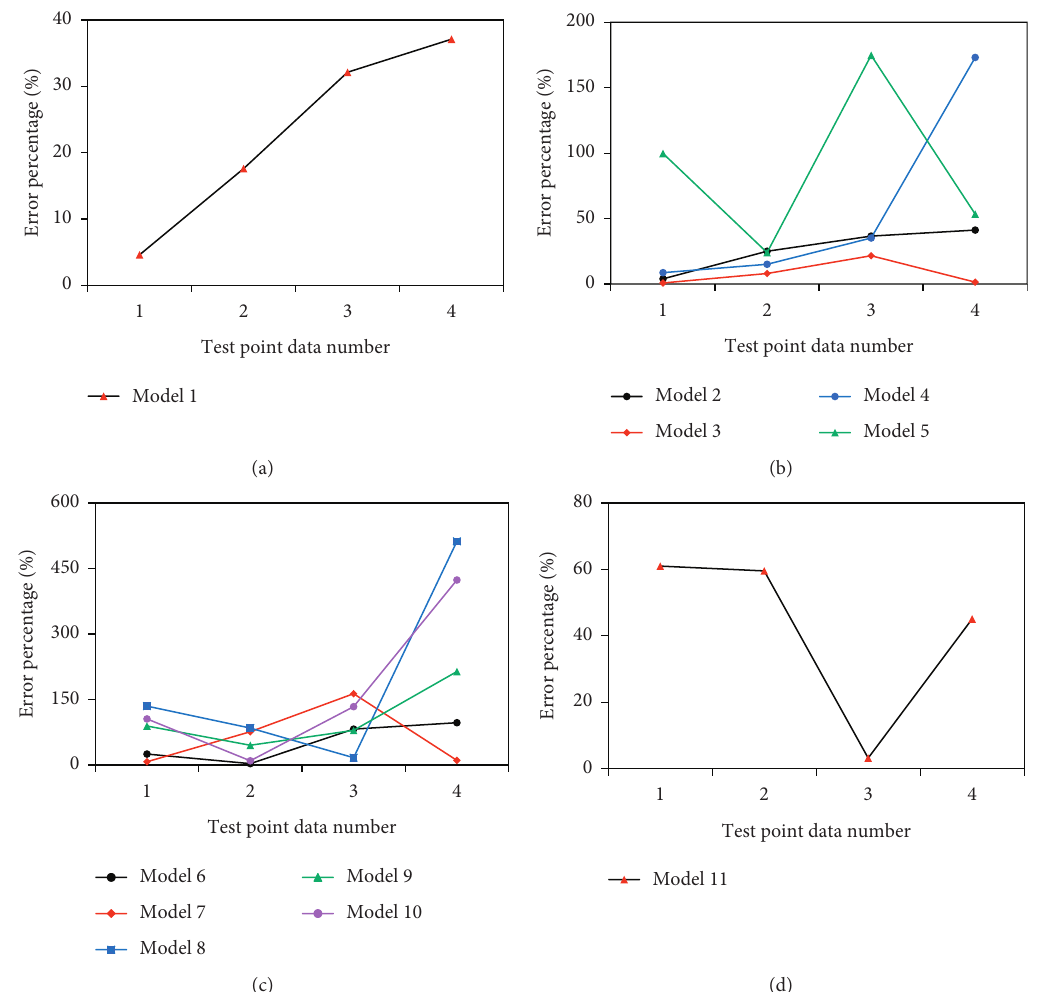
Figure 1: The prediction error of the multiple regression model: (a) binary regression; (b) ternary regression; (c) quaternary regression; (d) five-element